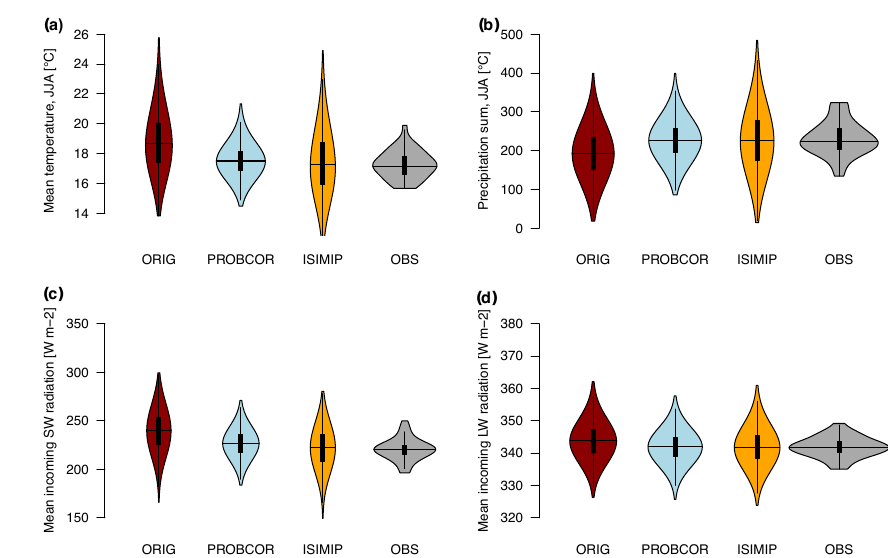
Figure 3. Evaluation of the resampling bias correction methodology for the study area in Central Europe for (a) temperature, (b) precipita- tion, (c) incoming short-wave radiation and (d) incoming long-wave radiation. Both sides of each violin are constructed as rotated, equal-area kernel density estimates, and a standard box plot is drawn inside each